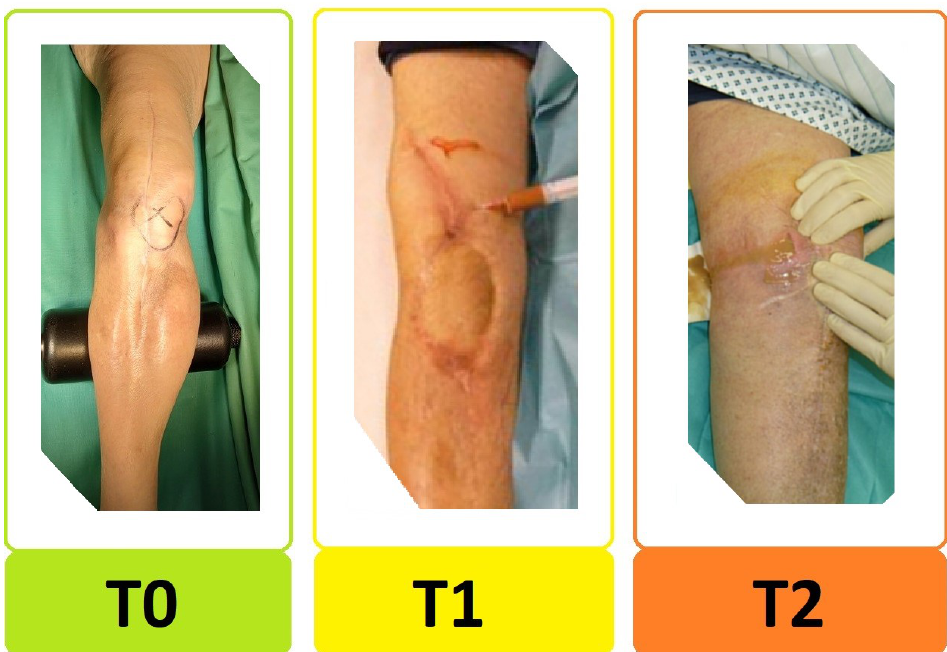
Figure 2. Preoperative periarticular soft tissue condition. The new “ T- status” distinguishes between : T0 = good soft tissue condition, T1 = bad soft tissue condition, and T2 = periarticular fistula or significant soft tissue defect requiring flap/plastic surgery.